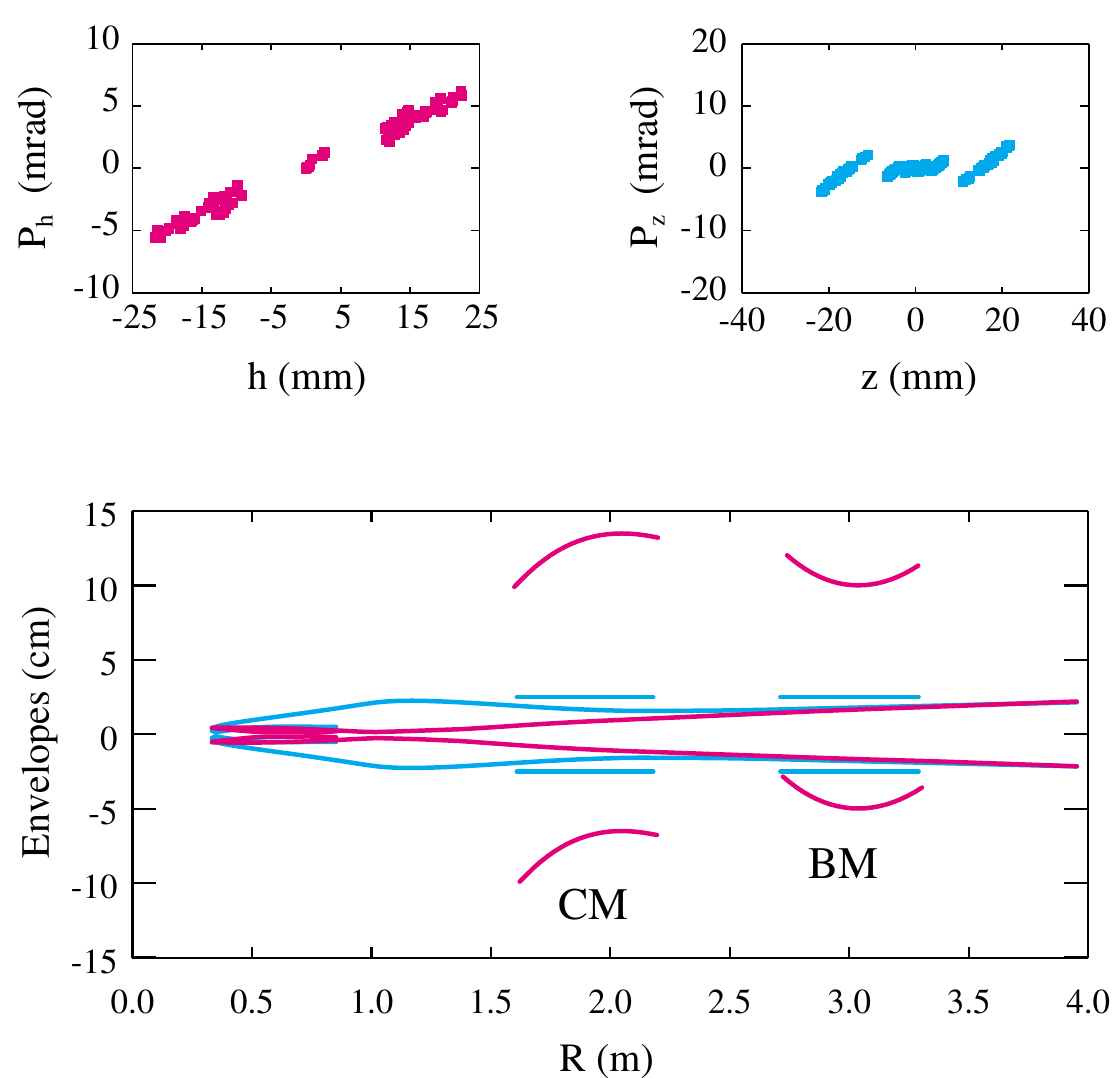
FIG. 9. (Color) Beam emittances and envelopes for K (cid:4) 2 : 5 . The structure of the figure is the same as that of Fig. 7. Unlike the other examples, the mean equilibrium orbit radius in this case is not maximum, instead it is equal to R extracted from equilibrium orbits with larger R shown results correspond to the Ar 15 (cid:3) ion beam obtained from the Ar 6 (cid:3) ion beam with the energy of 2.9 MeV per nucleon. The parameters of the beam-guiding elements are B